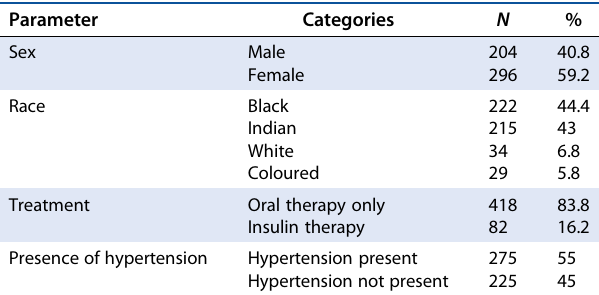
Table 1: Demographic profiles and disease